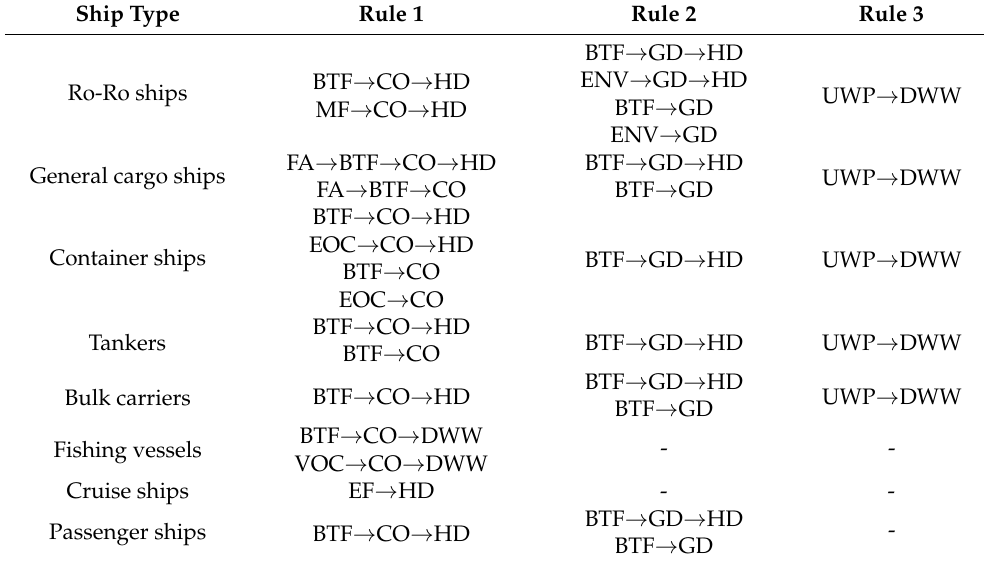
Table 11. Summary of the